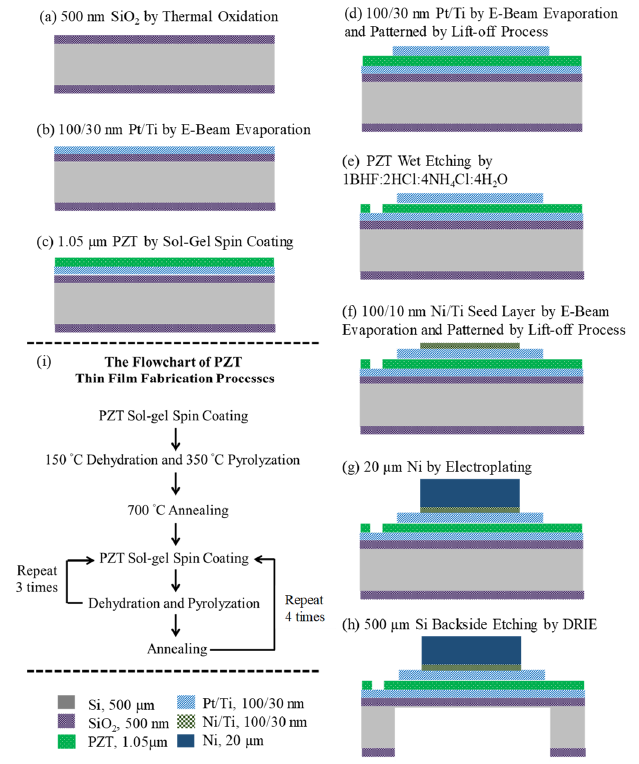
Figure 3. The fabrication processes of the sensor: ( a–h ) overall fabrication processes. ( i ) The flowchart of the PZT thin-film deposition.